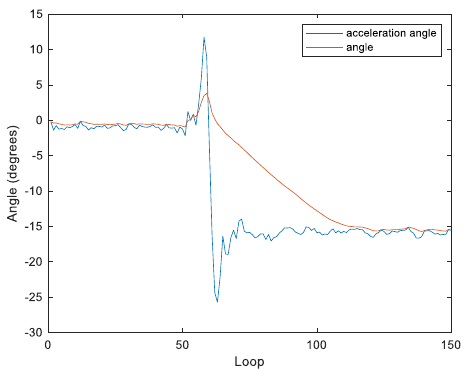
Figure 9. The reliability of the acceleration with R = 0.75.